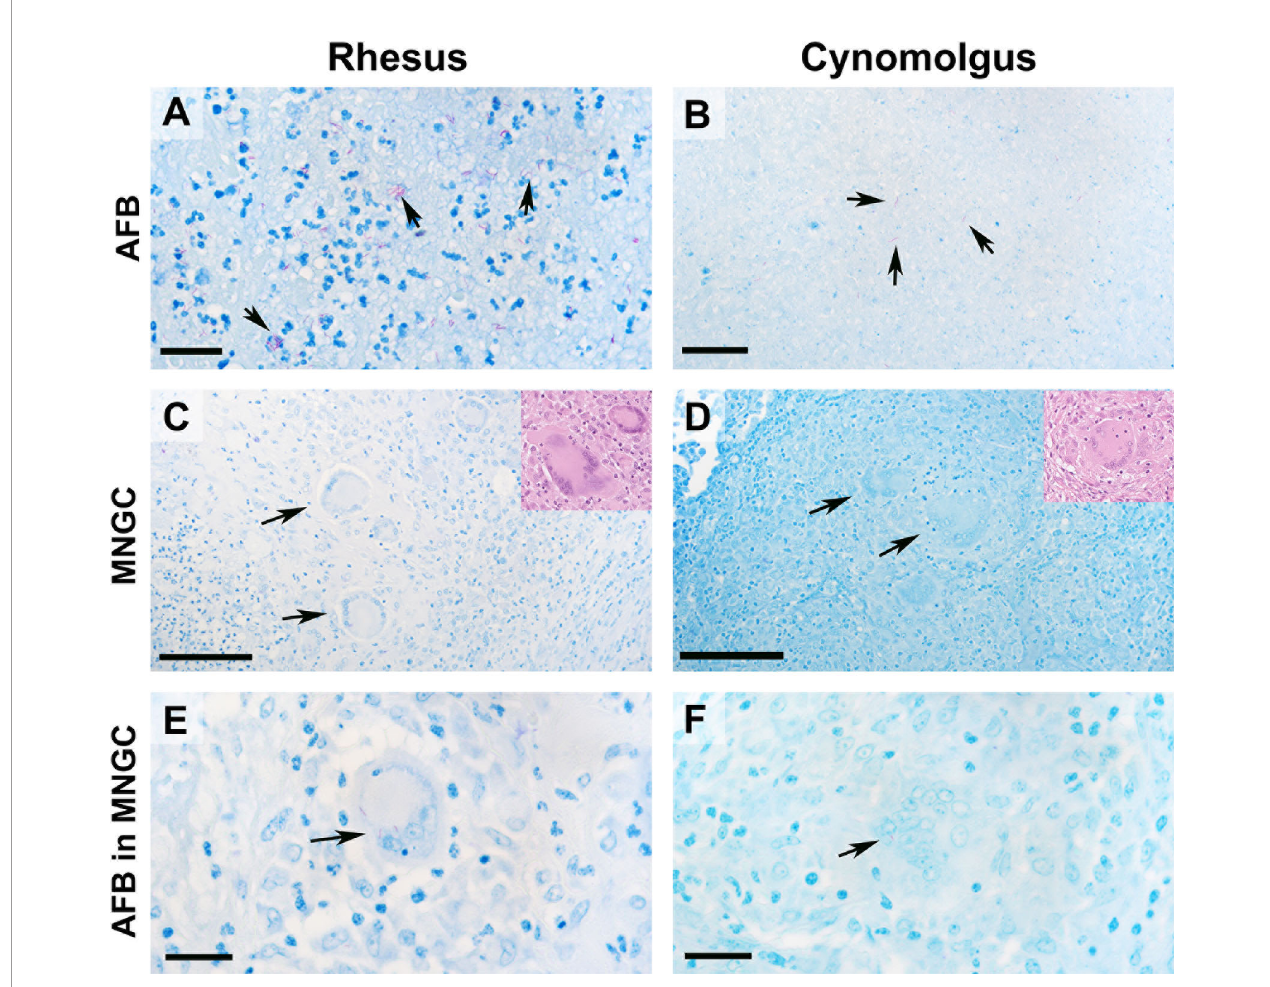
FIGURE 4 | AFB bacilli were most abundant in category 6 granulomas in both rhesus and cynomolgus macaques. Representative images of AFB staining and multinucleated giant cells ZN (inserts HE). AFB were most abundant in category 6 granulomas in both species (A, B) . In RM, AFB were frequently seen grouped together whereas AFB in CM were more often seen singularly within the necrotic core. MNGCs were identi fi ed in both species (C, D) with 12wpc category 6 granulomas having the highest number. RM on average had a higher proportion of MNGCs. AFBs were noticed within MNGCs in both species, although not frequently (E, F) . Bars in micrograph = 200µm. Representative images from 2 slides per animal at each time point (week 4 & 12 = 4 RM & 4